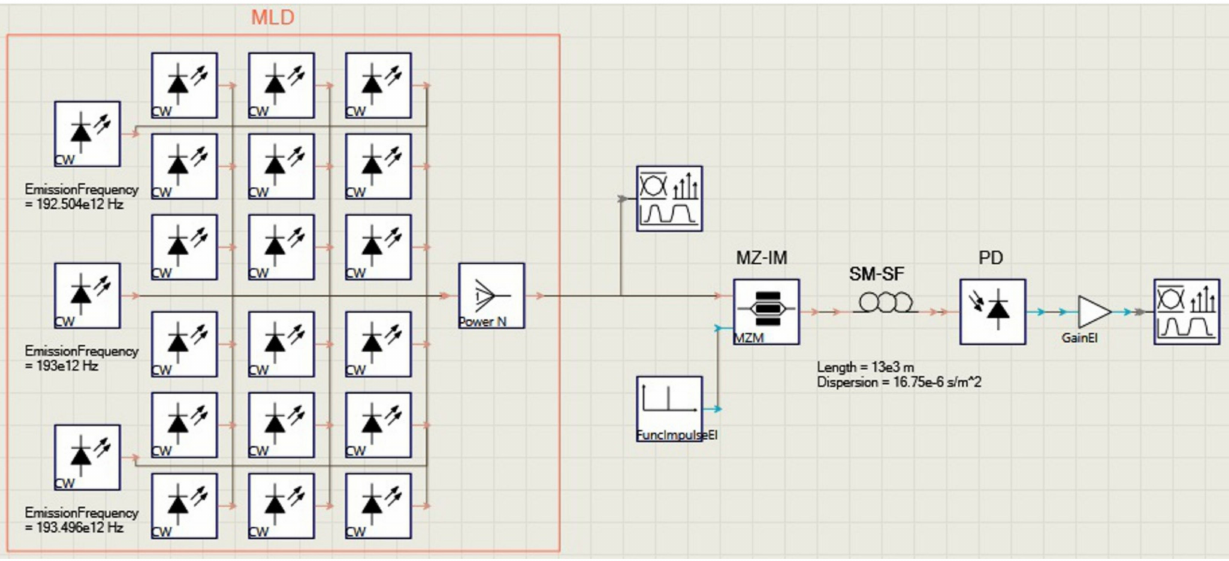
Figure 4. Layout of the simulated MPF in VPIphotonics software to obtain the filtering of microwave signals.